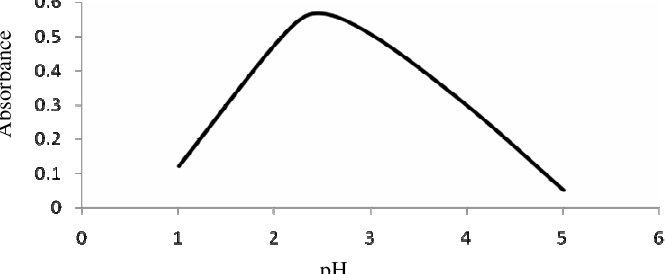
Figure 3. Effect of pH of buffer solution on the absorbance of pioglitazone-BCG ion-pair complex.